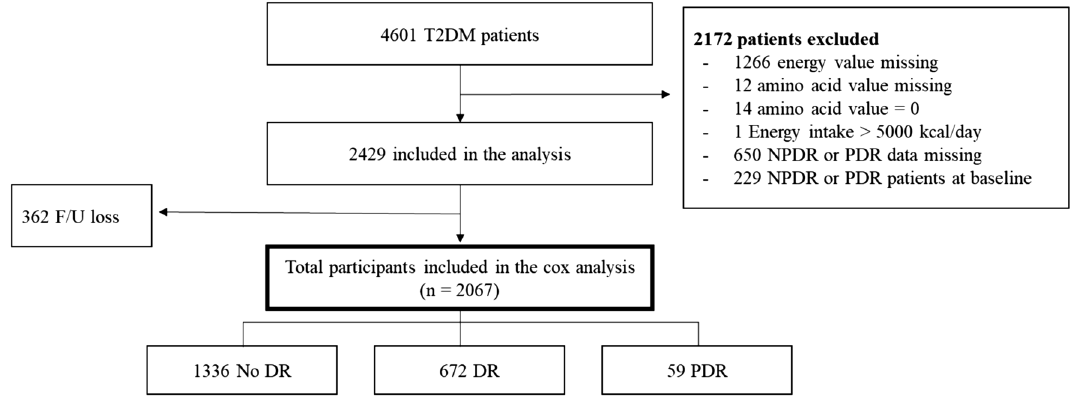
Figure 1. Study progression. DM diabetes mellitus; NPDR non-proliferative diabetic retinopathy; PDR proliferative diabetic retinopathy; DR diabetic